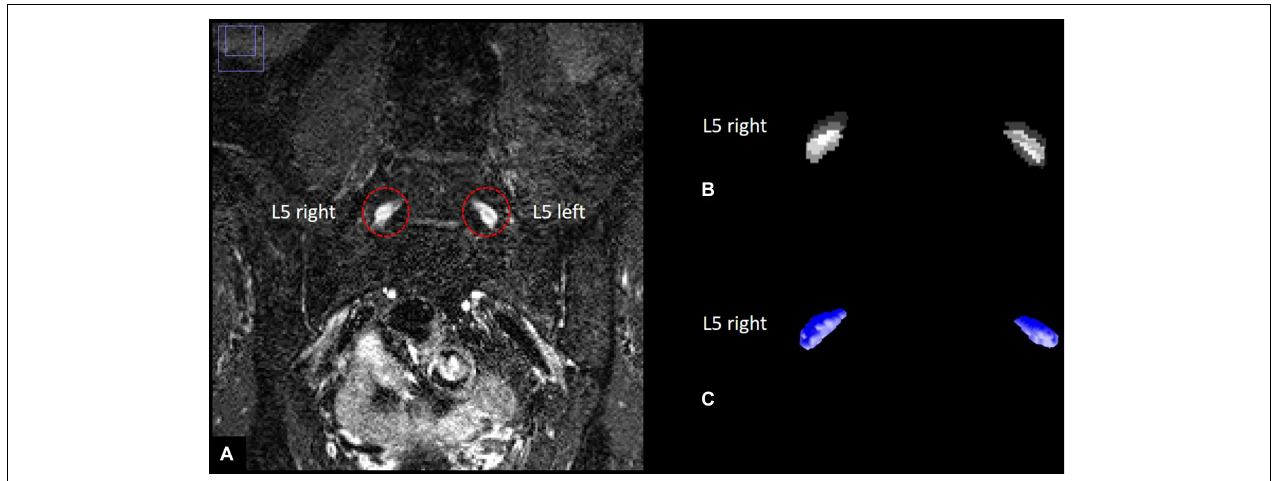
FIGURE 2 | Human dorsal root ganglia (DRG) segmentation. (A) Left and right L5 dorsal root ganglion on a T2–weighted, three–dimensional inversion recovery sequence with sampling perfection with application–optimized contrasts using different flip angle evolution. (B) Stacks of binarized masks of the left and right L5 dorsal root ganglion. (C) Three-dimensional reconstruction of DRG